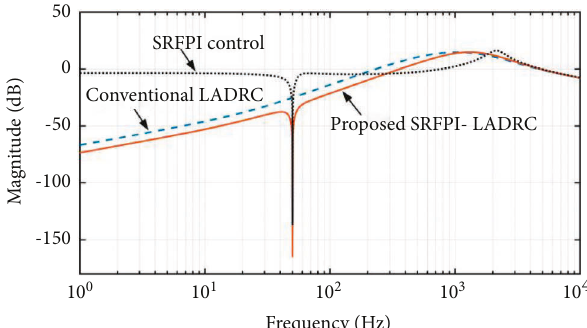
Figure 14: Bode magnitude plots of v control